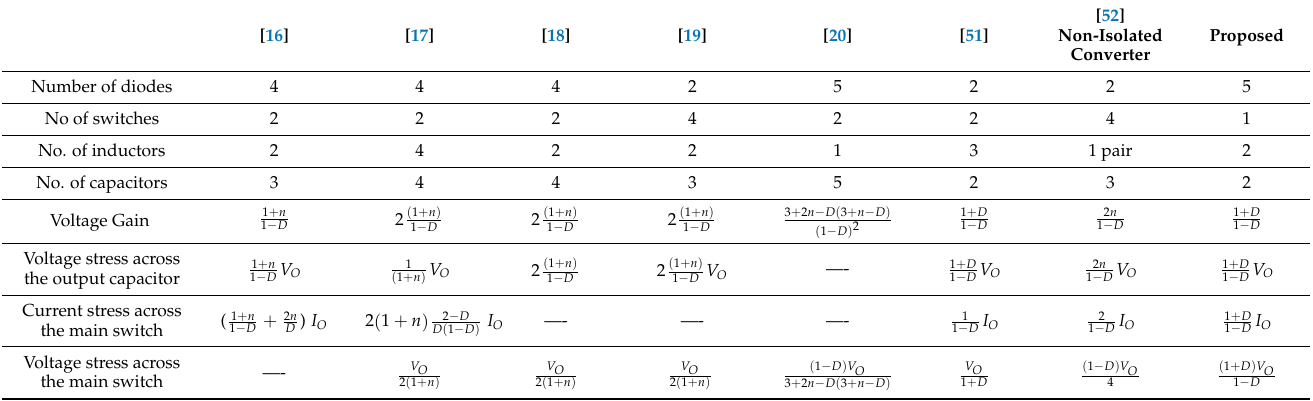
Table 1. Comparison between the proposed and other boost